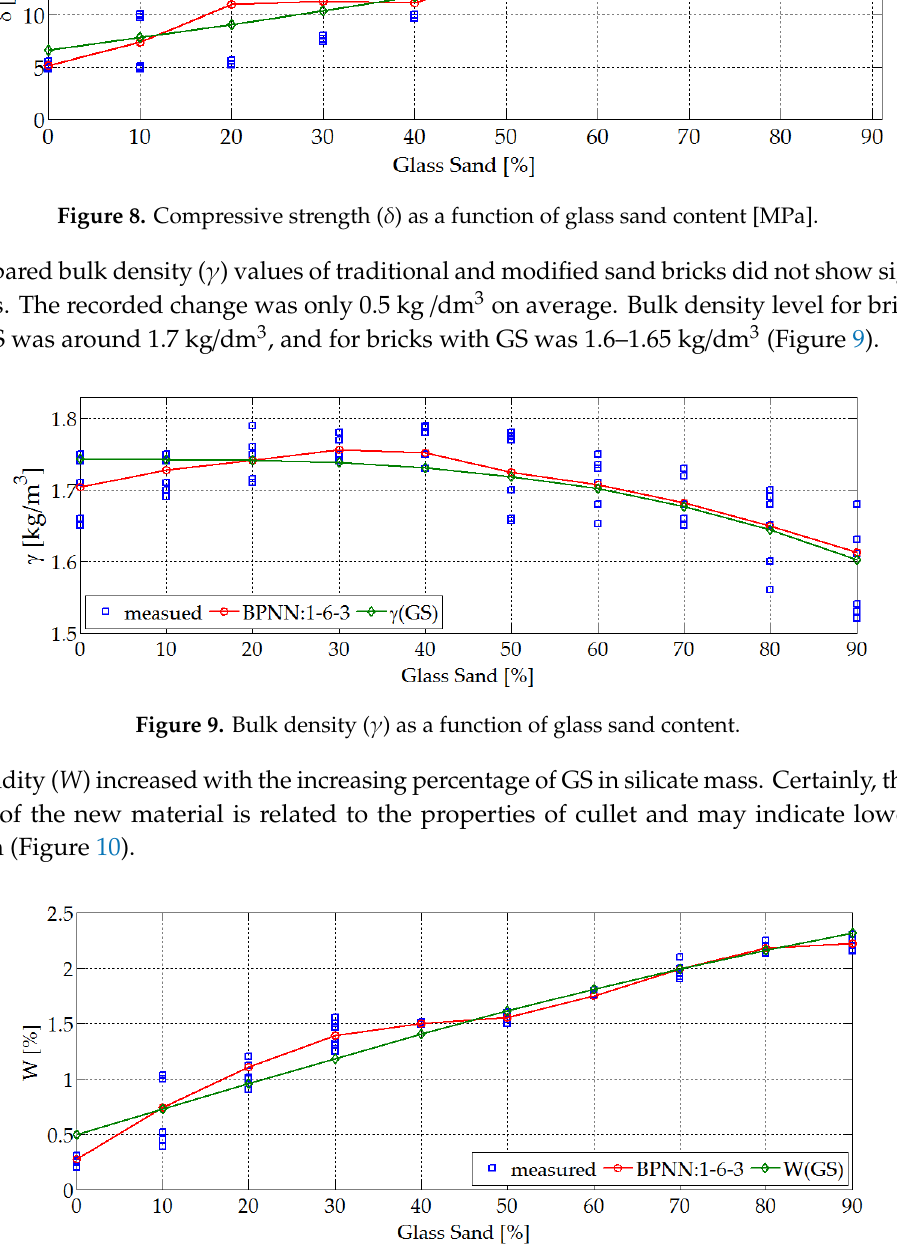
Figure 10. Humidity ( W ) as a function of glass sand content